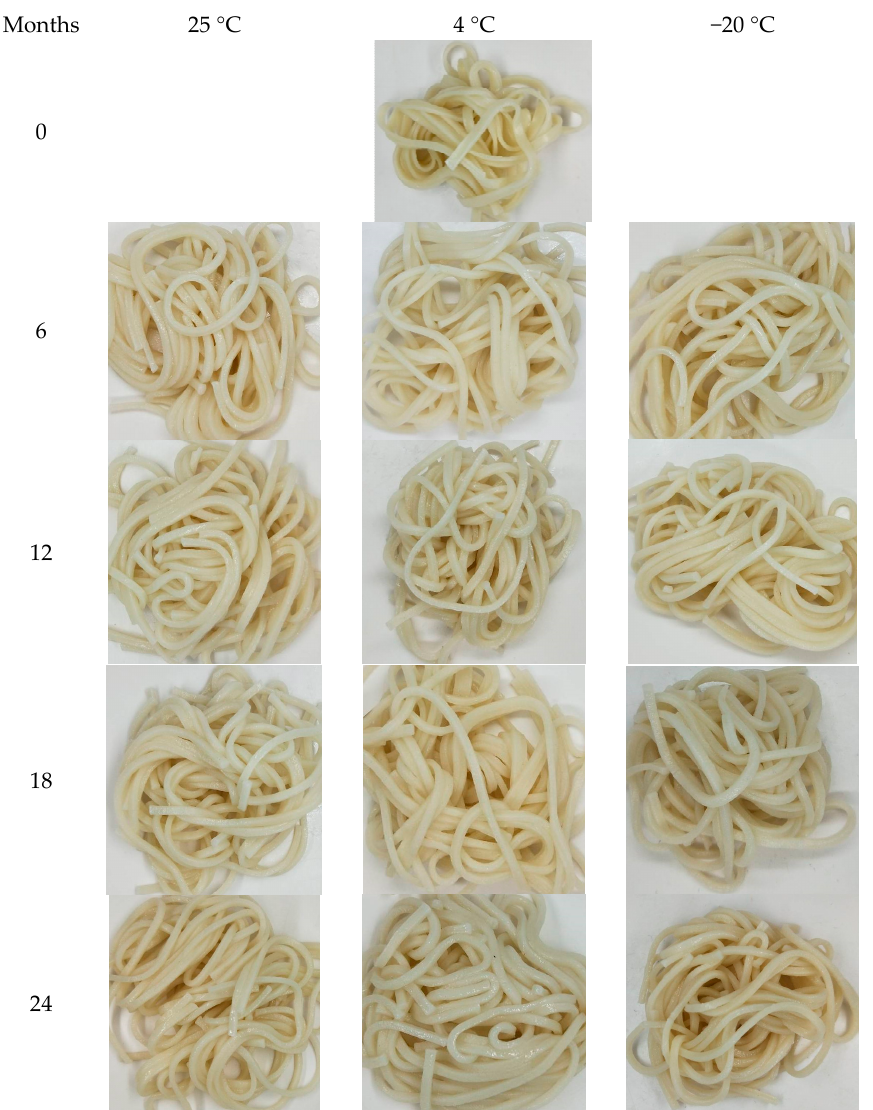
Figure 3. Appearance (after cooking) of cooked wheat noodles fortified with isomaltodextrin during different storage periods at different storage temperatures.